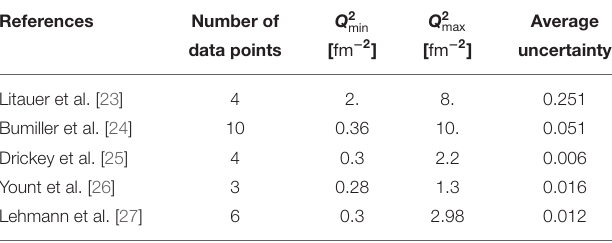
TABLE 1 | Summary of the experimental data considered in the analysis.